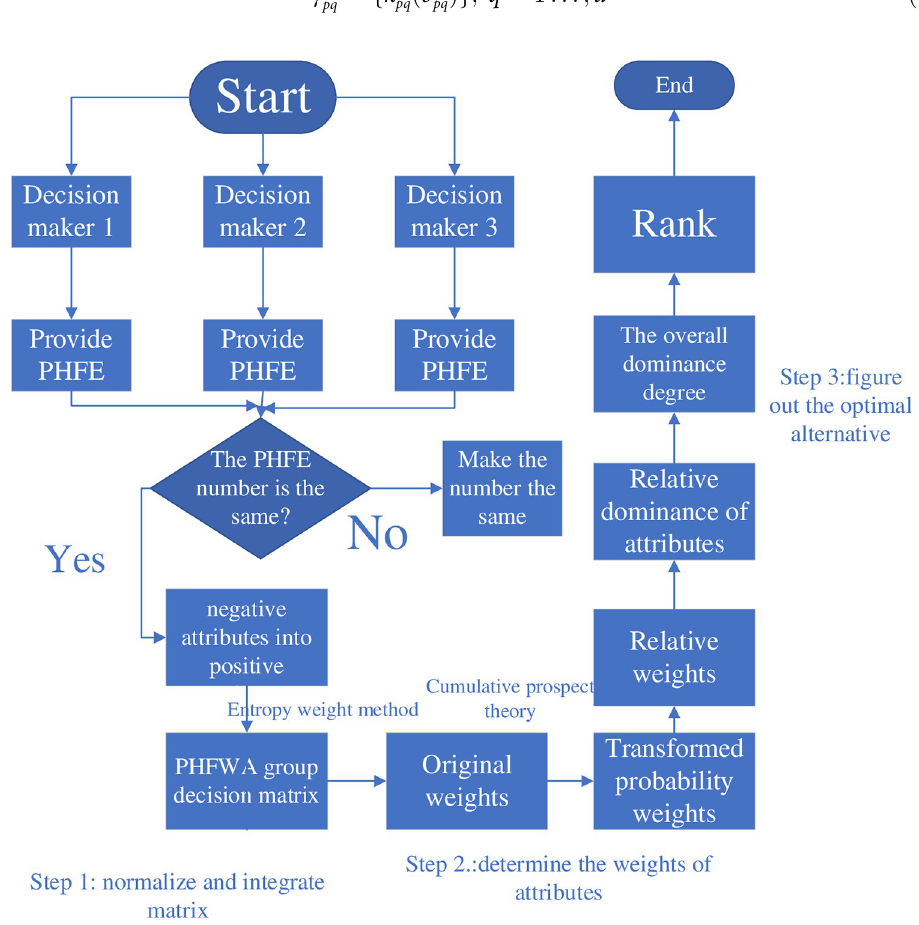
Fig 1. The framework of the probability hesitant fuzzy MAGDM using extended